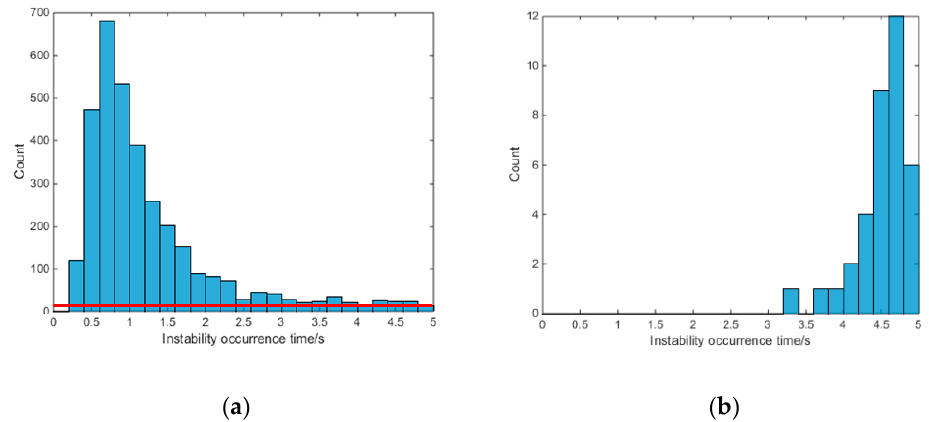
Figure 8. Histogram of instability occurrence time: ( a ) total testing unstable instances; ( b ) uncertain unstable instances remaining at a response time of 0.50 s.